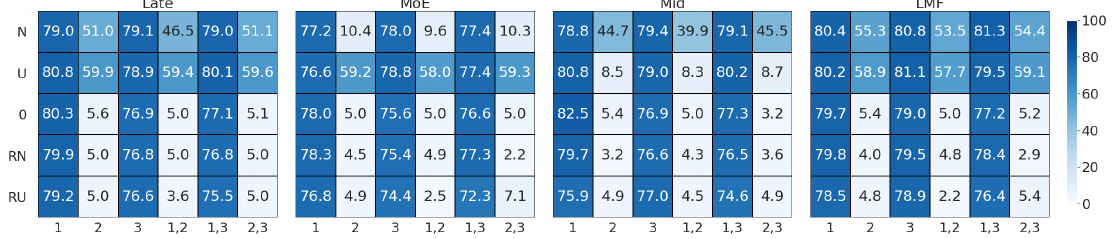
Figure 5. Accuracy [%] of a texture classification achieved while testing different fusion methods on degraded data from the HaTT dataset. Leading modality played a decisive dominant role, which resulted in a decreased quality in case of its degradation.